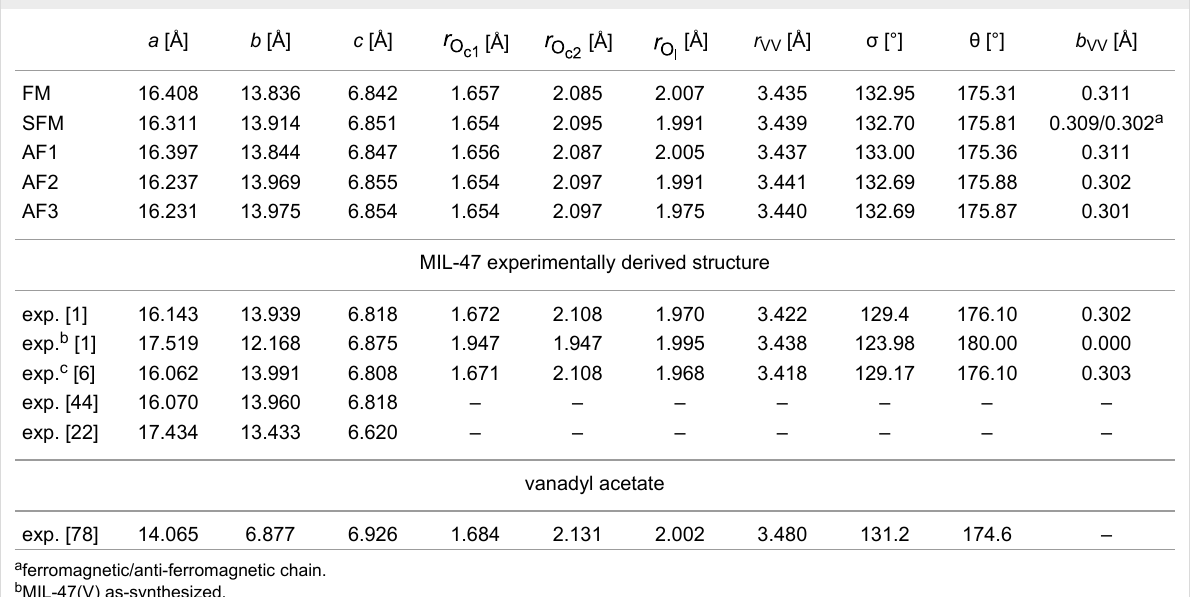
Table 2: Structural parameters of the equilibrium volume-optimized structures. a, b , and c : lattice parameters; ,